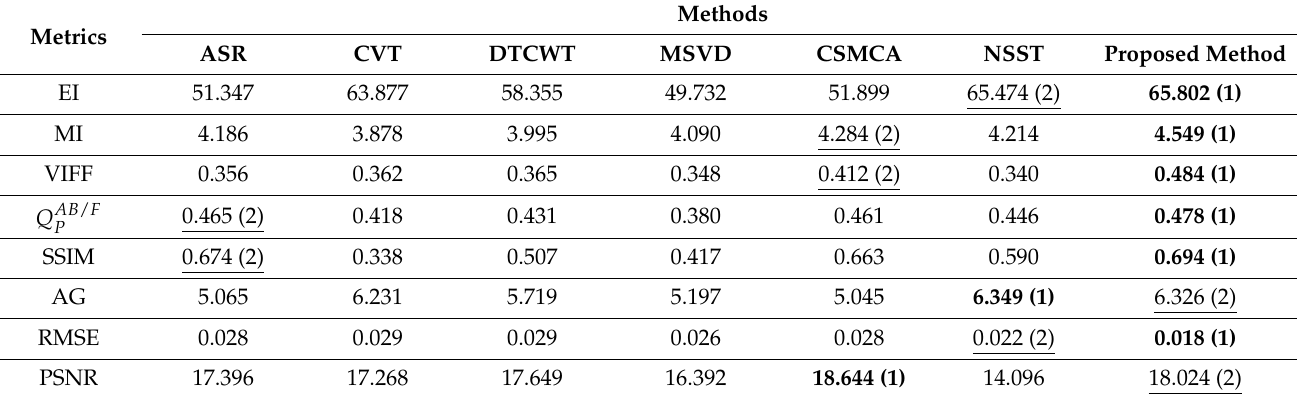
Table 5. Quantitative analysis of the state-of-the-art methods for MRI-CT (set-15) dataset.